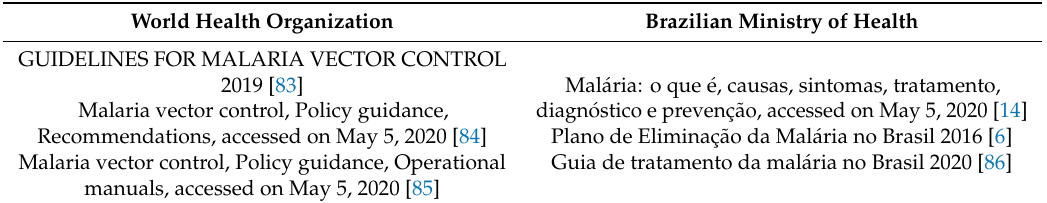
Table 1. Current Guidelines for Malaria Vector Control in the World and in